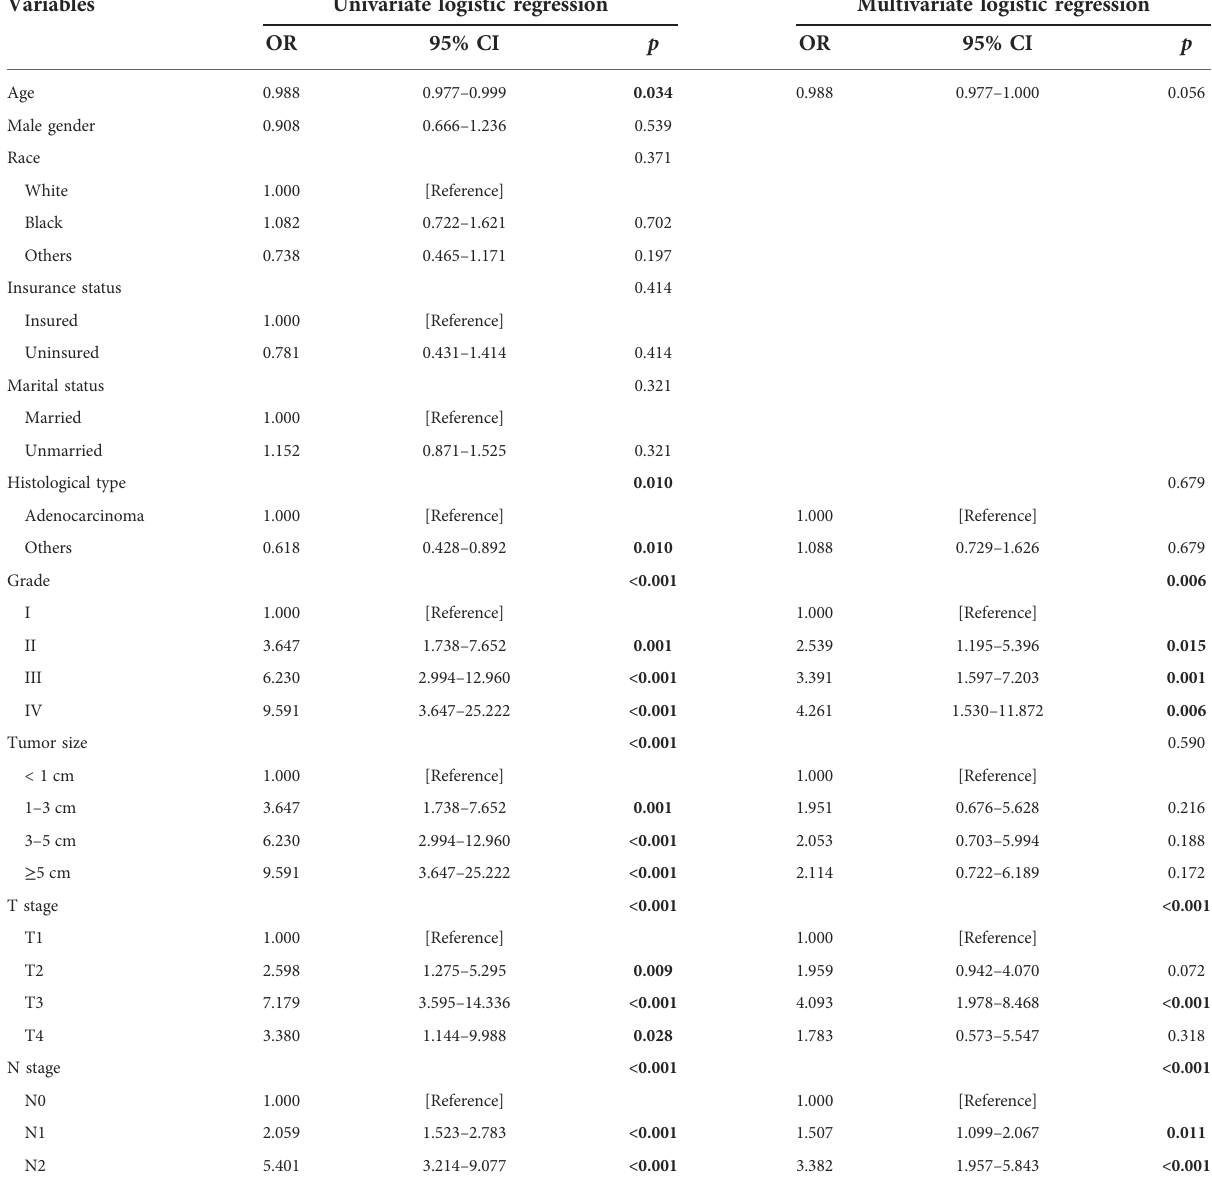
TABLE 2 Risk factors for liver metastasis in gallbladder cancer patients analyzed by logistic